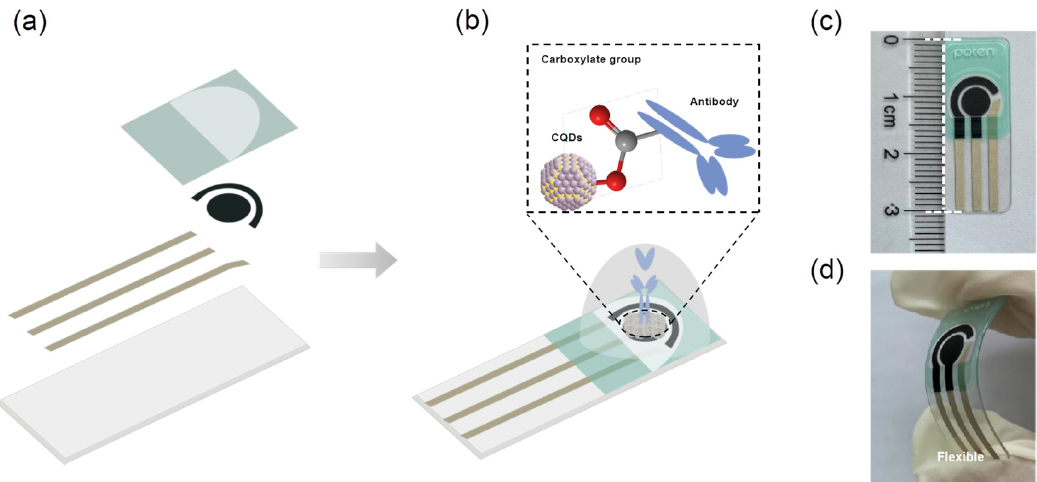
Figure 1. Fabrication of the CQD-modified electrode as the MPO protein immunosensor. ( a , b ) Schematic diagram of the preparation process for immunosensor; ( c , d ) Optical images of the flexible CQD-modified electrode.